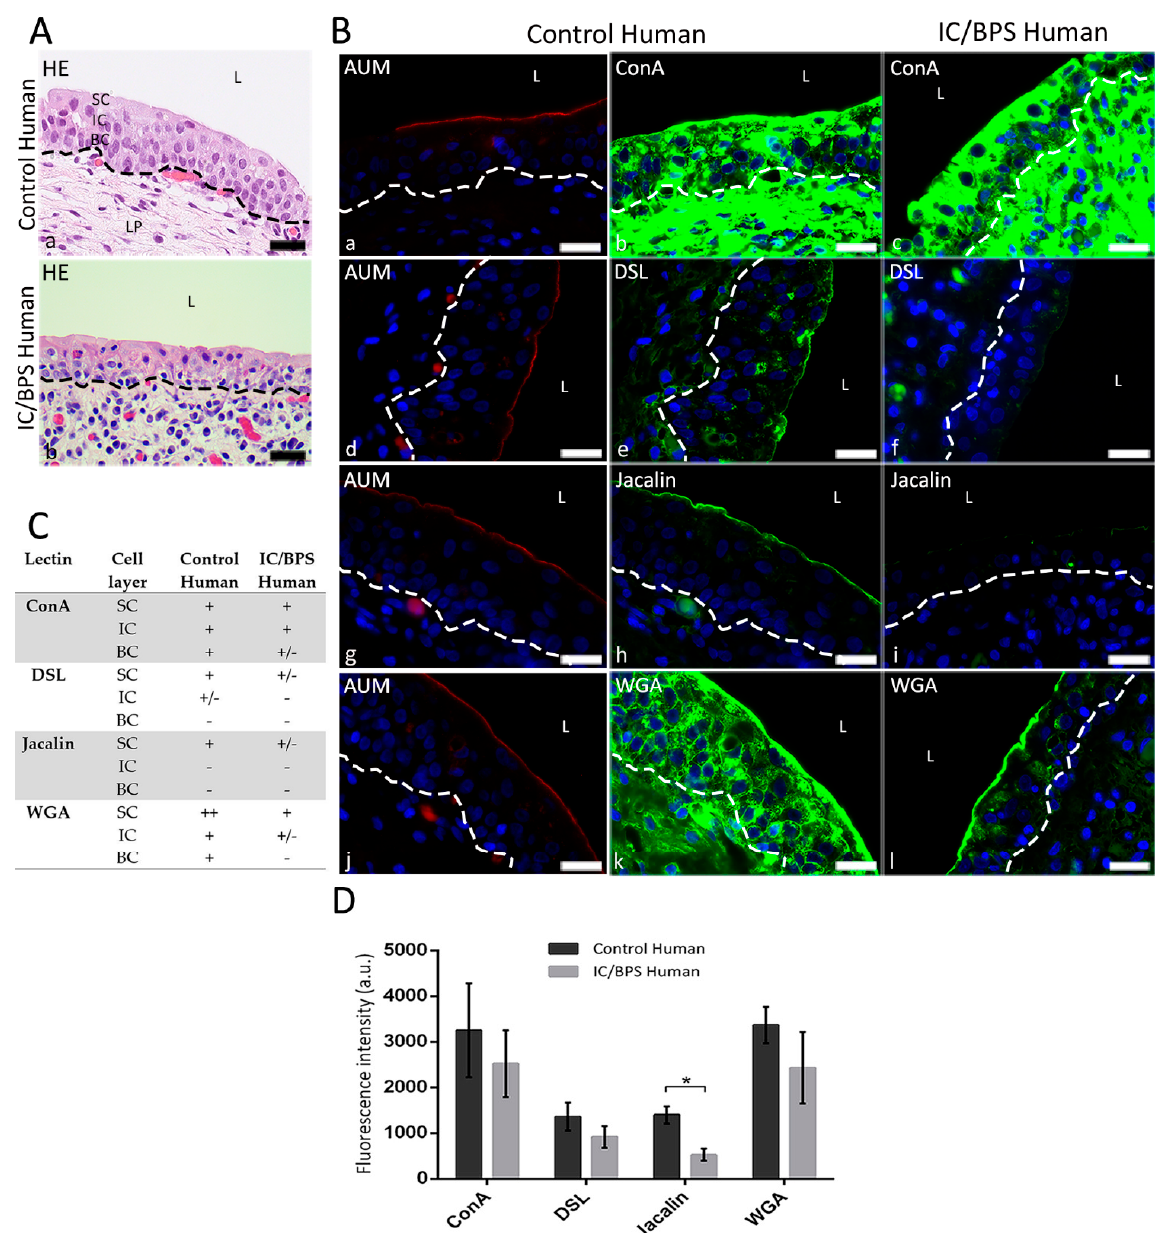
Figure 2. Lectin binding to normal and IC/BPS human urothelium. ( A ) Representative photomicrographs of HE-stained paraffin sections ( a , b ). ( B ) Representative photomicrographs of AUM immunolabeling (red fluorescence) and lectin fluorescence (green) in normal ( a , b , d , e , g , h , j , k ) and IC/BPS human urothelium ( c , f , i , l ). ConA labeling is very heterogeneous, ranging from very intense to weak in urothelial cells of control tissue ( b ), whereas in IC/BPS urothelium, BC show exclusively weak labeling ( c ). DSL labeling is present in the cytoplasm of individual IC and in the cytoplasm and apical surface of SC of normal urothelium ( e ), whereas in IC/BPS tissue, the labeling of DSL is almost absent except the very weak labeling of the apical surface of SC ( f ). Jacalin specifically labels the apical surface of SC, ( h ), whereas the labeling is very weak in the whole IC/BPS urothelium ( i ). The WGA labeling extends homogeneously throughout the urothelium in normal tissue ( k ), whereas the labeling in IC/BPS tissue gradually increases from weak labeling in BC to the very intense labeling of apical surface and cytoplasm of SC ( l ). ( C ) Semi-quantitative analysis of lectin binding to urothelial cells per cell layer (SC, superficial cells; IC, intermediate cells; BC, basal cells). Binding of lectins is scored as ++ (very intense), + (intense), +/ − (weak) and − (very weak). ( D ) Fluorescence